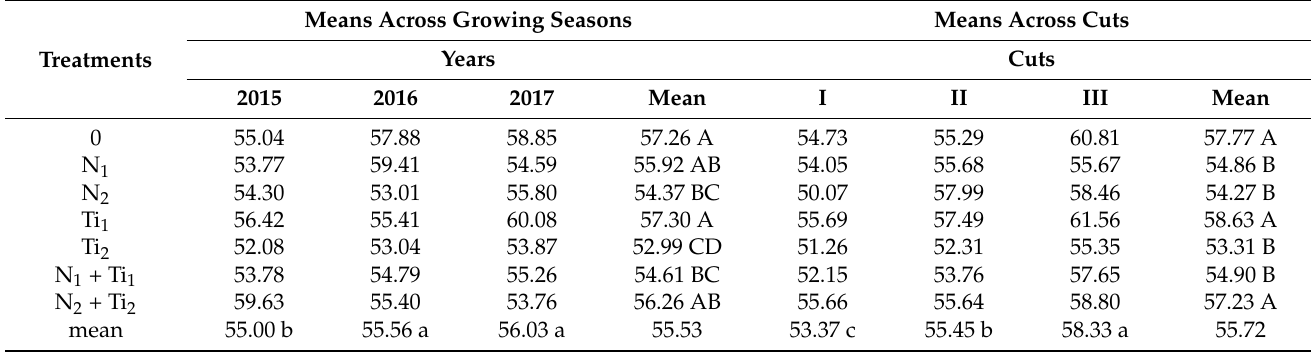
Different lowercase letters in the same row or different uppercase letters in the same column indicate significant differences between treatments. 0—control; N 1 —ammonium nitrate at a dose of 80 kg N ha − 1 ; N 2 —ammonium